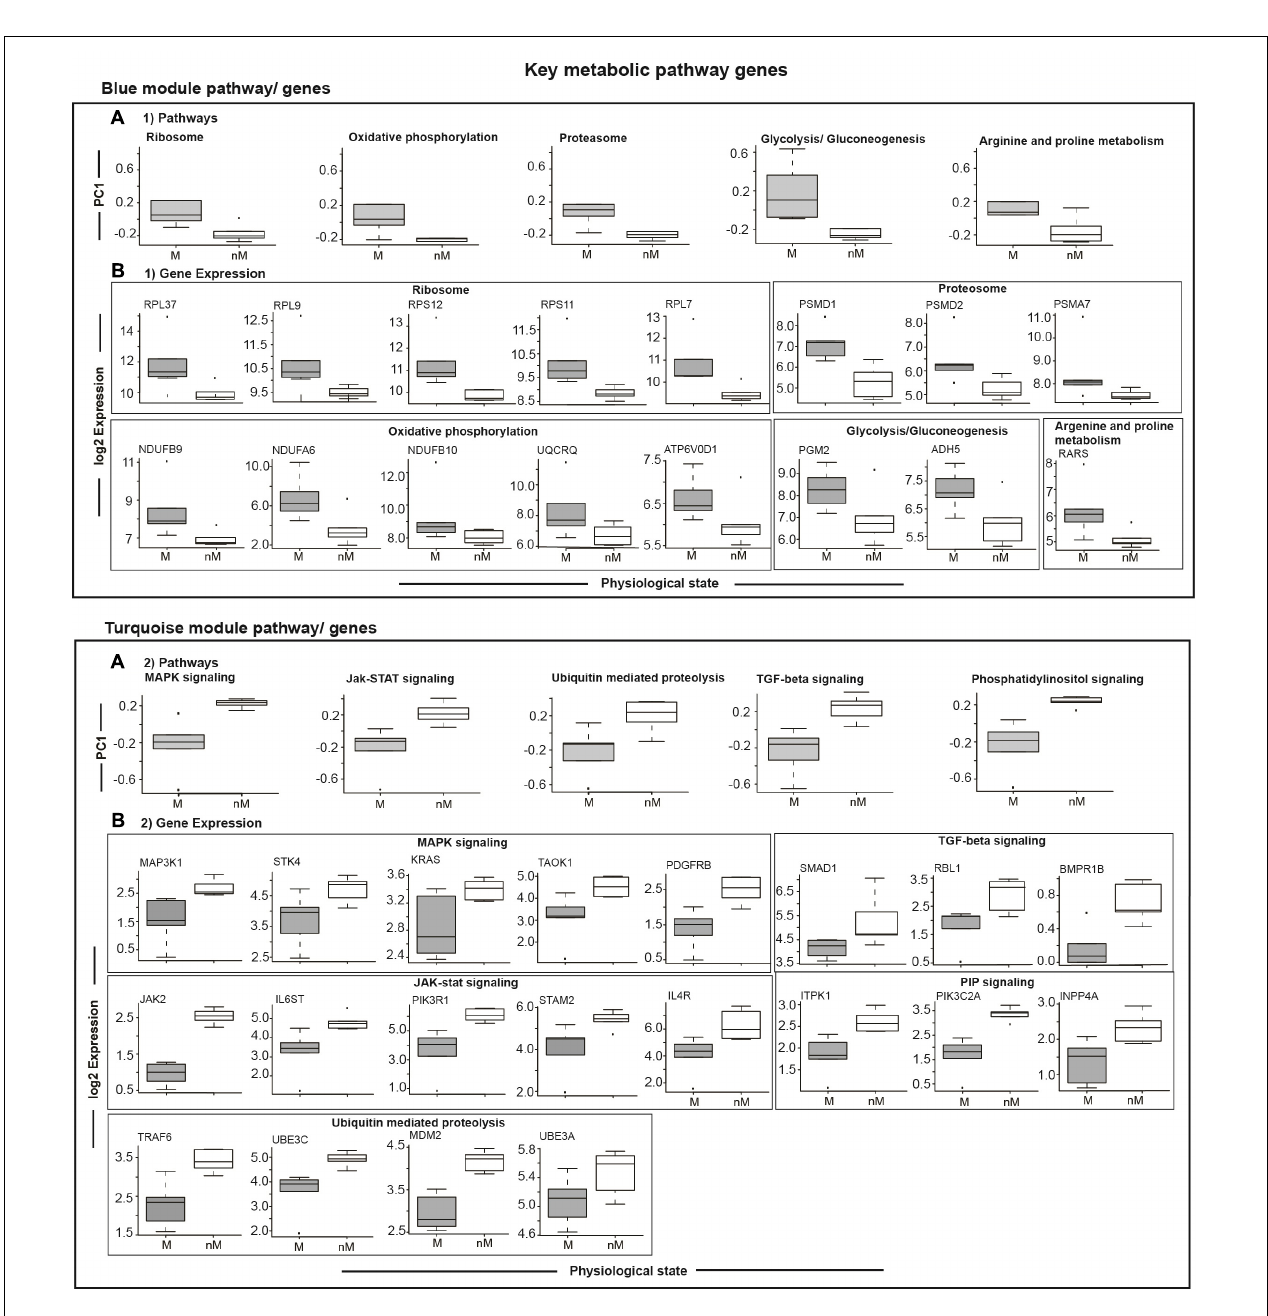
FIGURE 5 | Module specific selected relevant pathways and candidate genes. Top panel: (A1) shows differences in gene expressions comprising a particular pathway in the blue module, and in underneath boxed 2 panels (B1) are the log 2 FPKM expression values of coexpressed key upregulated genes enriched in different GO terms showing 5–95% intervals. Bottom panel: Boxplots in the top row show differences in gene expressions comprising a particular pathway in the turquoise module (A2) , and in the three panels underneath (B2) are the log 2 FPKM expression values of coexpressed key upregulated genes enriched in different GO terms showing 5–95% intervals. All plots compare migratory (M) and non-migratory (nM) states, and an outlier is shown as dot in each plot. Wilcox Rank sum test was used to determined significant difference between M and nM states. For significance, alpha was set at